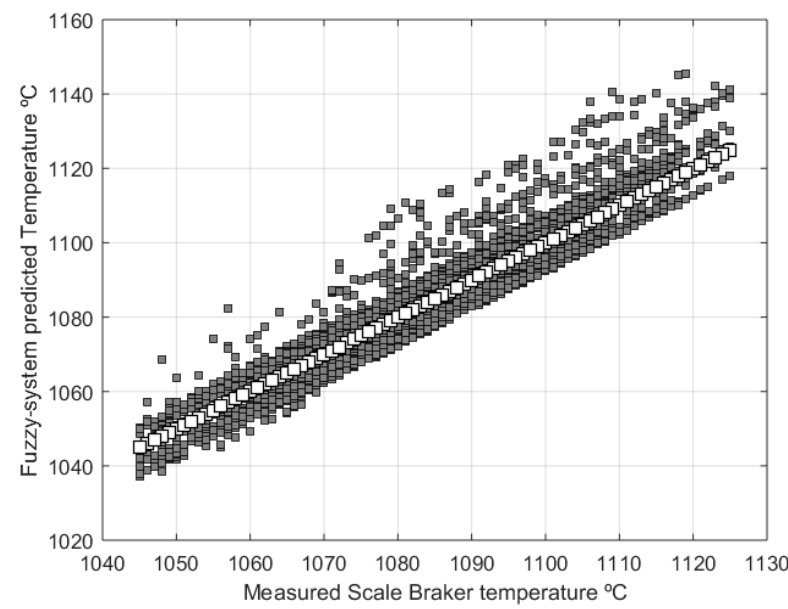
Figure 8. Scatter diagram of the 25-rule HL / FCM type-2 Sugeno GB model predicted scale breaker entry temperature.